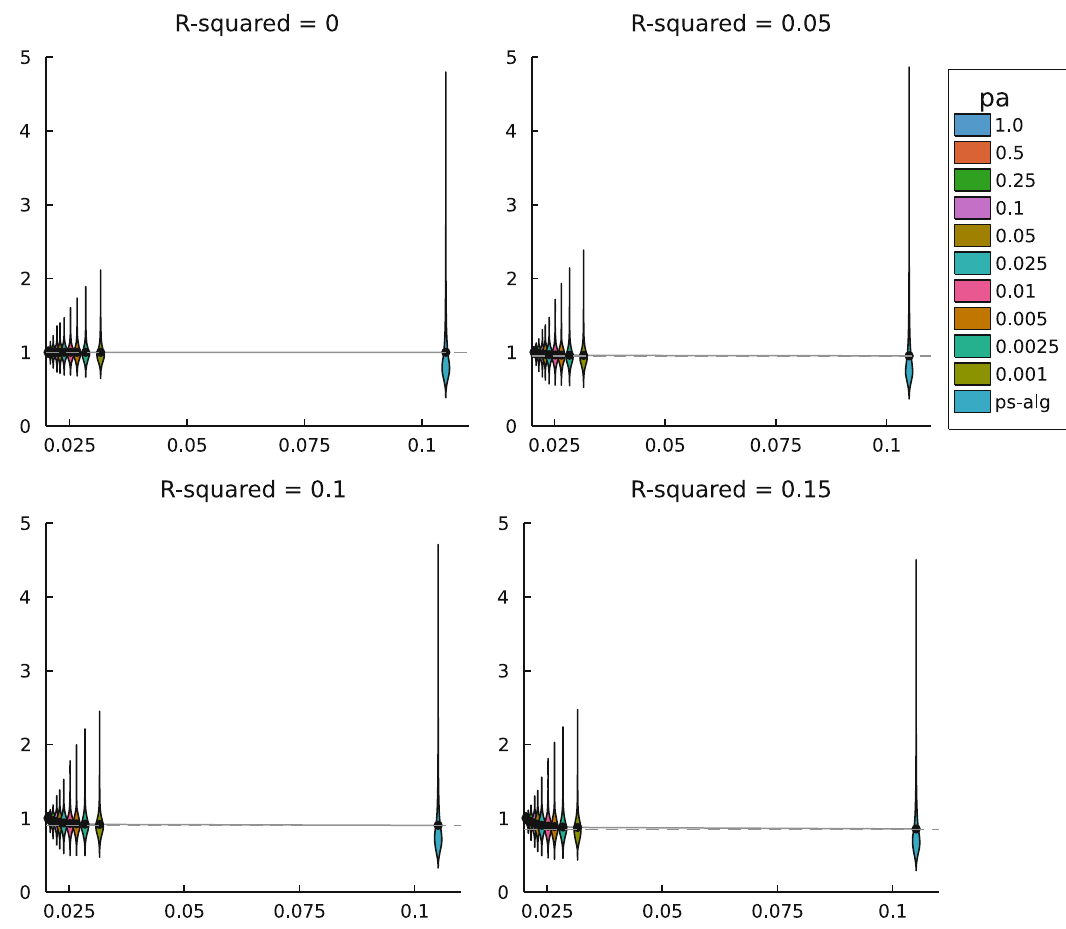
Figure 3: Distribution of MSE ( y - axis ) against assignment correlation ( x - axis ) for di ff erent designs, lognormal covariates. Note: The plots are violin plots indicating the distribution of the MSE for di ff erent designs. The dashed line shows the expected MSE if covariates are perfectly balanced ( R 1 − 2 ) . The black dots indicate the mean of the distribution of MSE for each design, connected with a gray